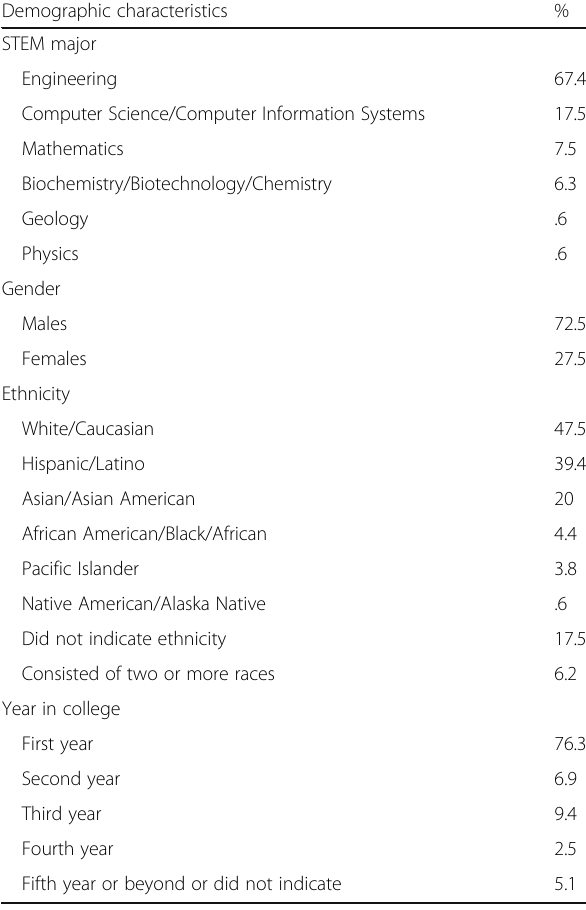
Table 2 Characteristics of the physics students